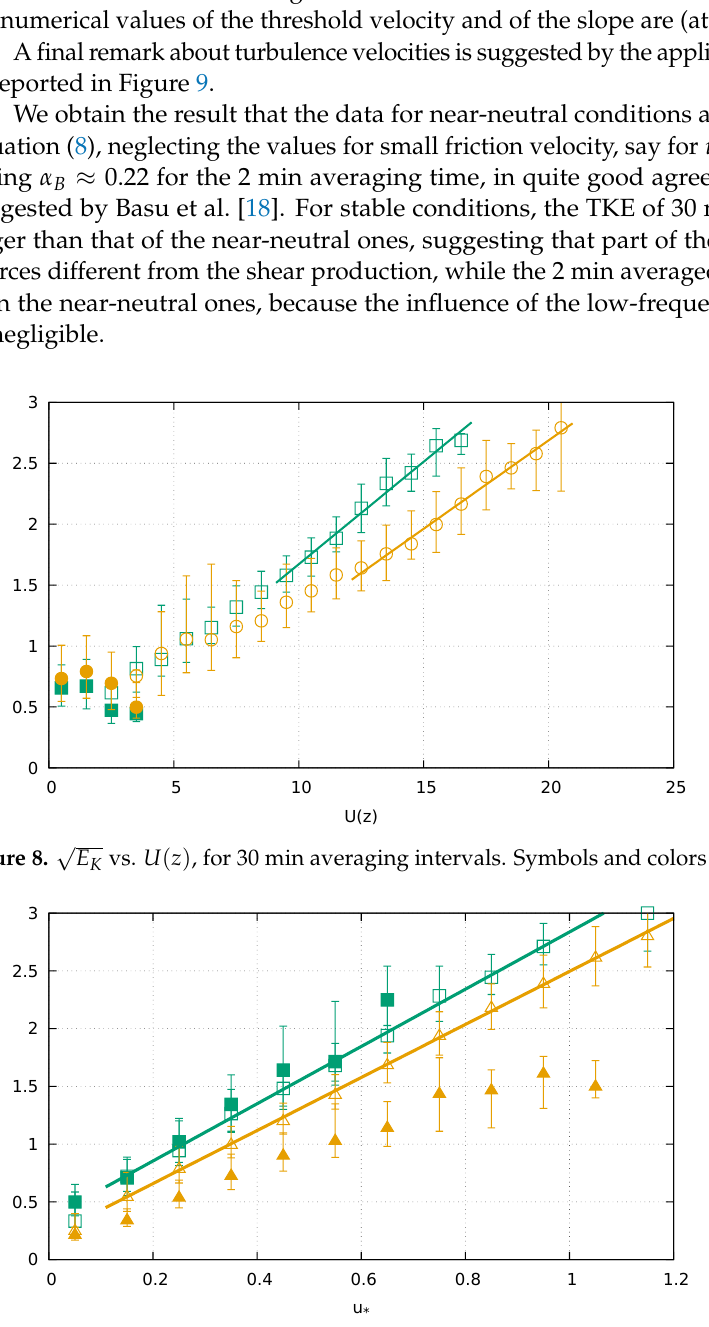
√ E K vs. u ∗ , averaged over the layer 2 ÷ 9 m. Open symbols: near neutral conditions, Figure 9. closed symbols: stable conditions; squares: 30 min averaging time, triangles: 2 min averaging time. Lines: linear fit in the range u ∗ >